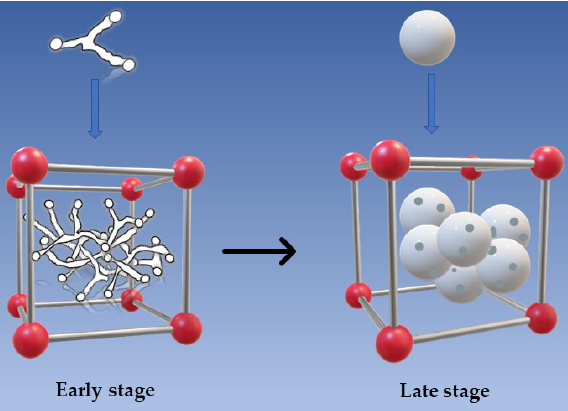
Figure 7. Crystal growth and evolution process.